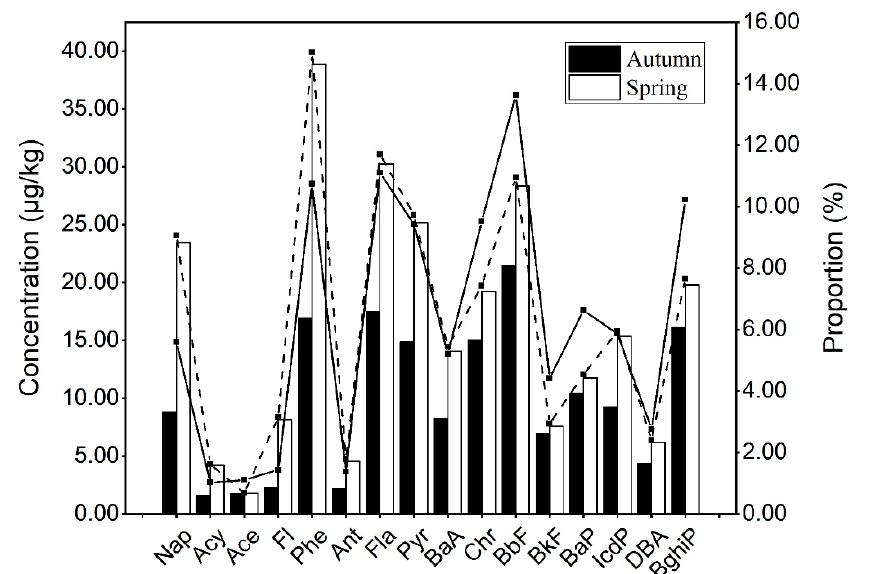
Figure 2. Composition distribution of PAHs in farmland soils in autumn and spring. The bar charts represent the concentration of each PAH. Line charts represent the proportion of each PAH, with the solid black line indicating autumn and the dashed black line indicating spring.